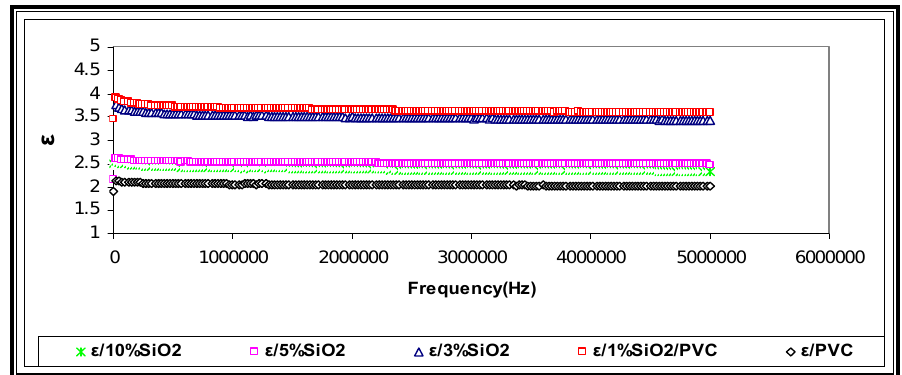
Fig. 13: Frequency dependent dielectric constant of PVC &SiO